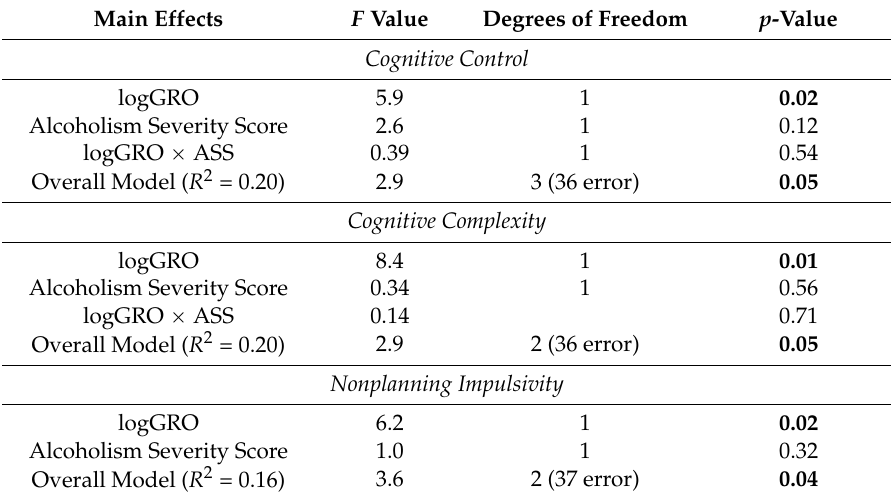
Figure 4. The scatter plot shows the relationship between plasma GRO concentration and Barratt Impulsivity Raw Score for Cognitive Complexity for n = 40 adult male African-American participants. A trendline indicates the strength of the linear correlation. The table provides Pearson correlation coefficients ( r ) between logGRO and BIS subscales. Relationship between Plasma GRO Levels and Barrett Impulsivity Scores in Males with Alcoholism. Table 2. Linear regression modeling of logGRO (growth-related oncogene) on BIS outcomes.